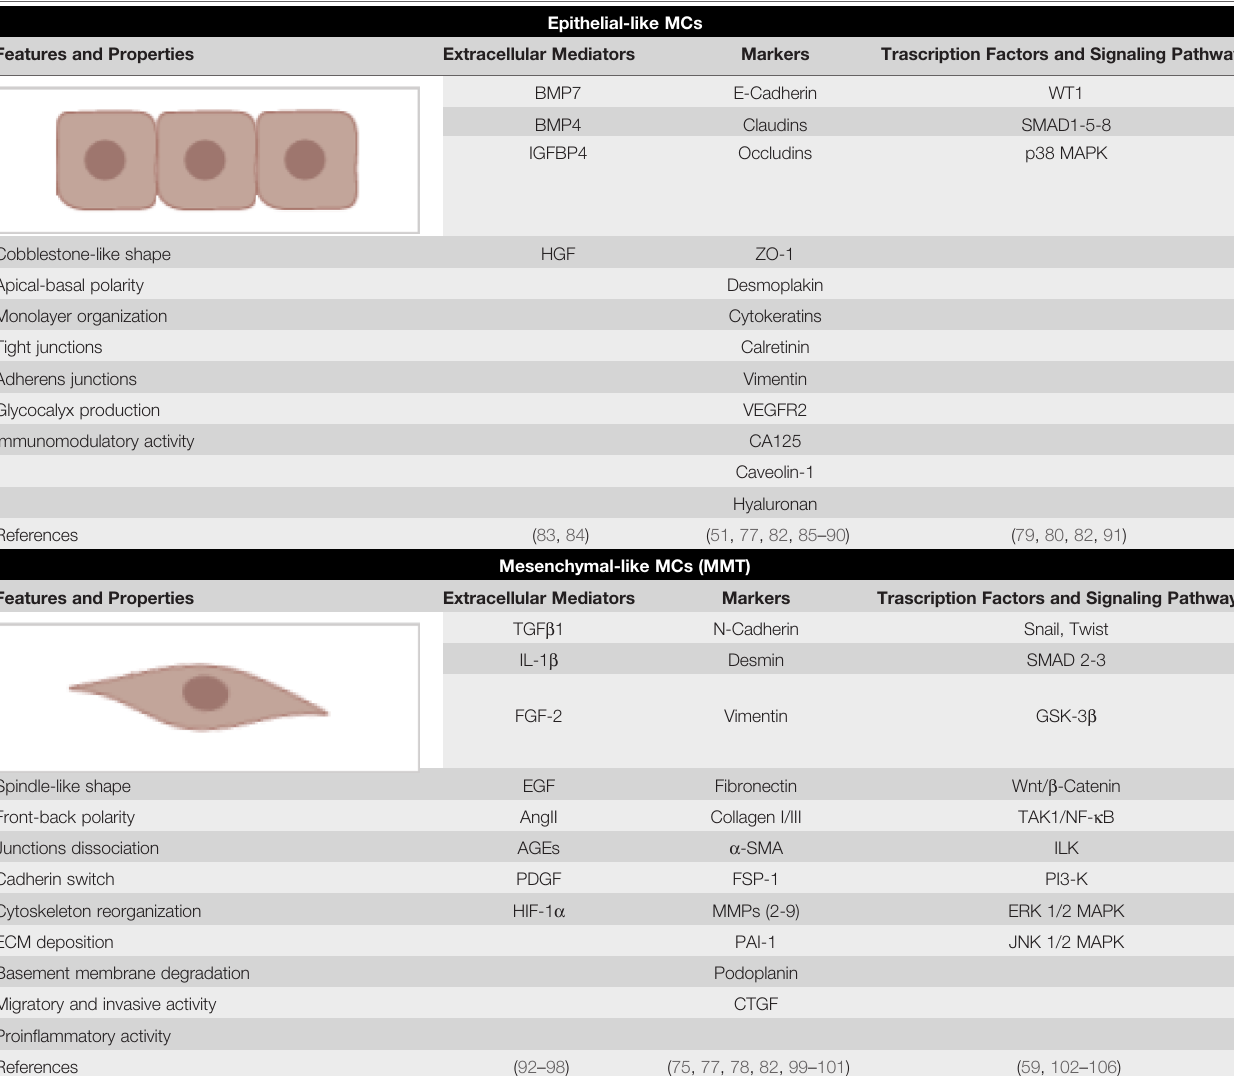
TABLE 2 | Epithelial-like and mesenchymal markers of MCs. The main extracellular regulators of MC plasticity, molecular markers and signaling pathways implicated are